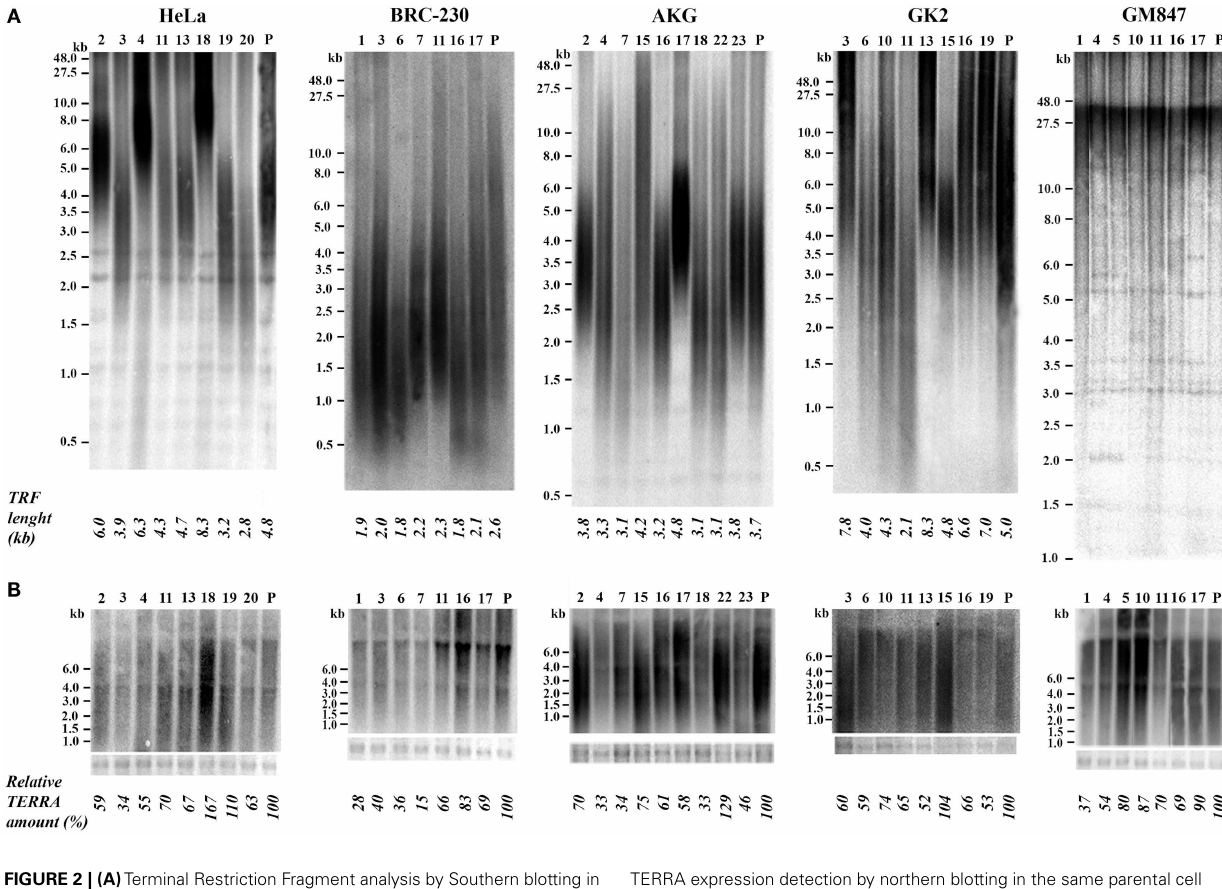
FIGURE 2 | (A) Terminal Restriction Fragment analysis by Southern blotting in parental (P) HeLa, BRC-230, AKG, GK2, and GM847 cell lines and in their clones (numbers on top). AverageTRF length is shown at the bottom. (B)